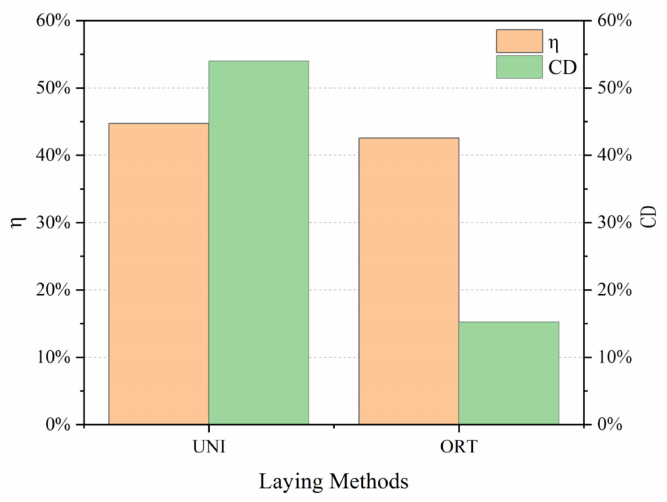
Figure 11. Bending coefficients of 3D armor material under different laying modes.